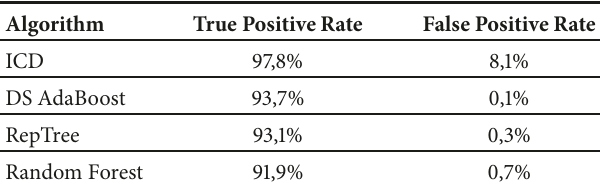
Table 1: True positive rate and false positive rate for different learning algorithms.